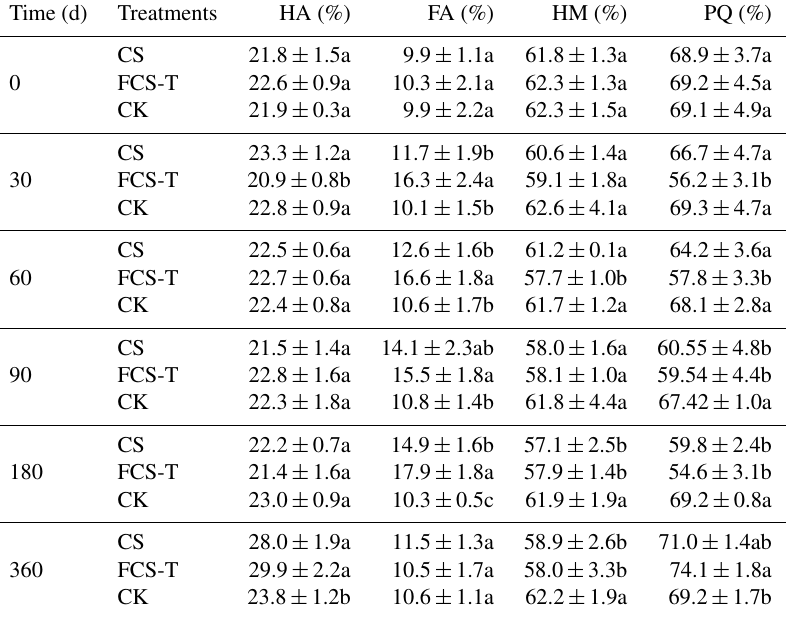
Table 5. Changes of relative content of each humic substance component and the PQ values in different treatments during the 0–360d period. Note that values are means ± SE. Means that do not share the same letter within a column of a given parameter and time (d) of the experiment are significantly different ( P < 0 . 05). HA, humic acid; FA, fulvic acid; HM, humin; CS, corn straw returned to the field; FCS-T, fermented corn straw treated with T. reesei returned to the field; CK, blank control treatment. Time (d) Treatments HA (%) FA (%) HM